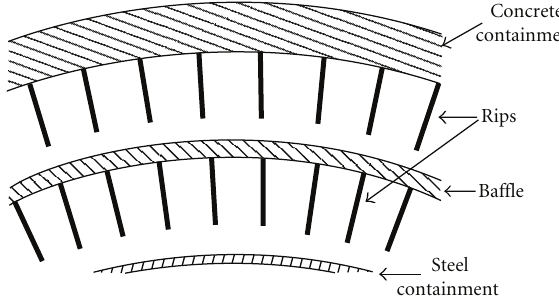
Figure 8: Improvement for heat removal using ribs